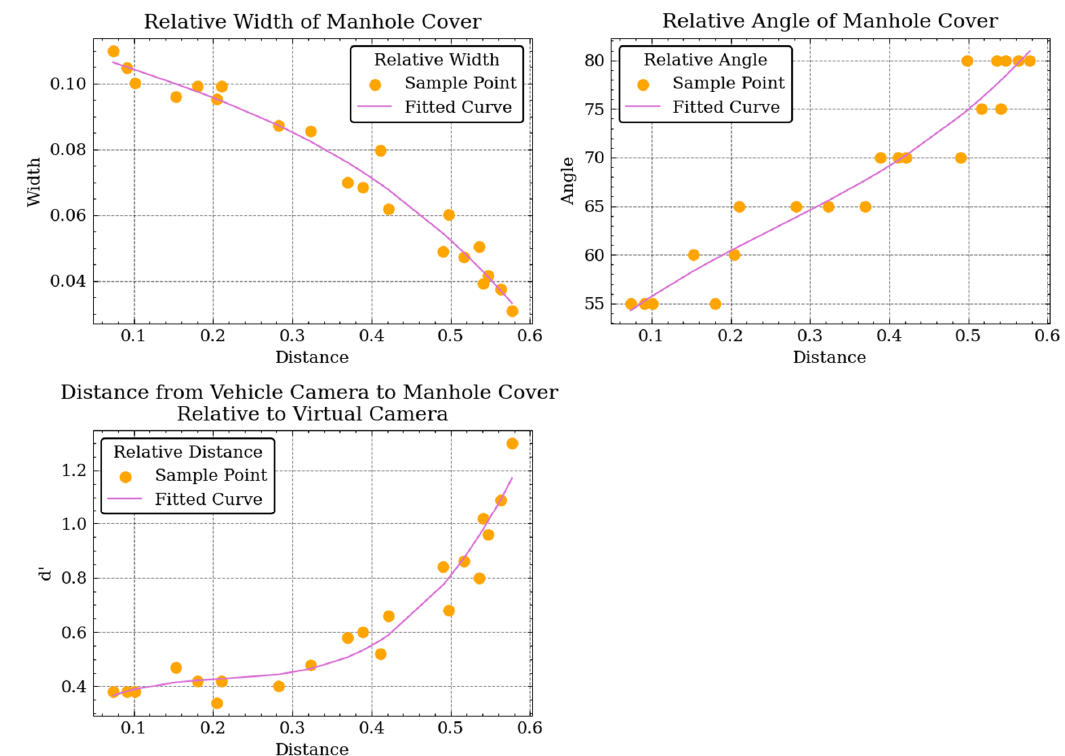
Figure 4. Linear fitting perspective transformation parameters, from left to right, are the width and angle of the pasted manhole cover sample and the distance from the vehicle’s camera.